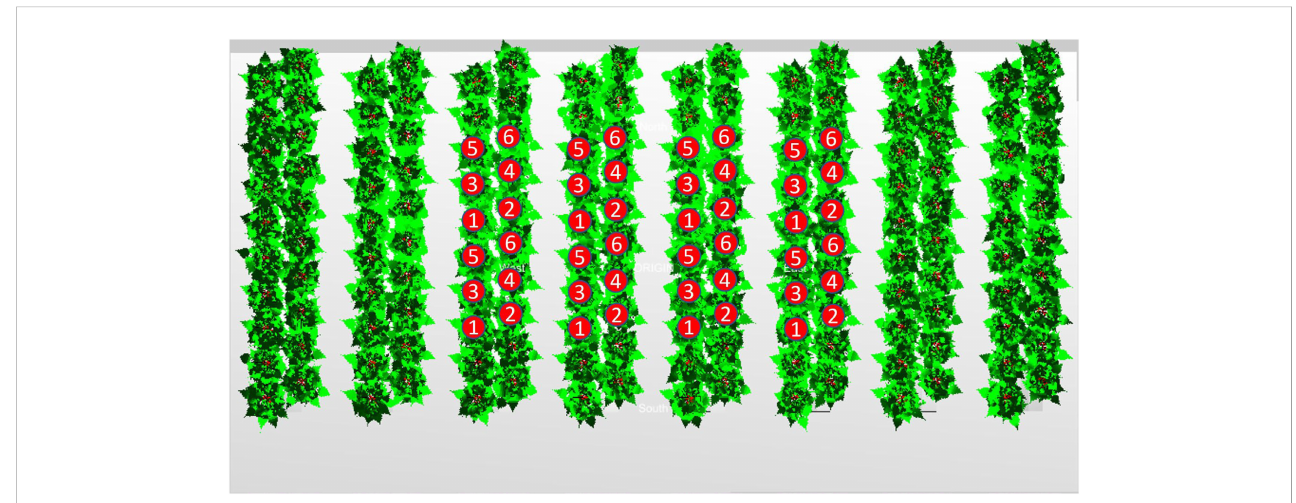
FIGURE 2 Top view of the reconstructed modelled tomato canopy with architectural parameters measured on 20 March (80 DAS). In each simulation two times six center plants were observed in each of four double rows. These eight groups of six plants each were considered repetitions of each other and the absorbed light of each lea fl et was used for further